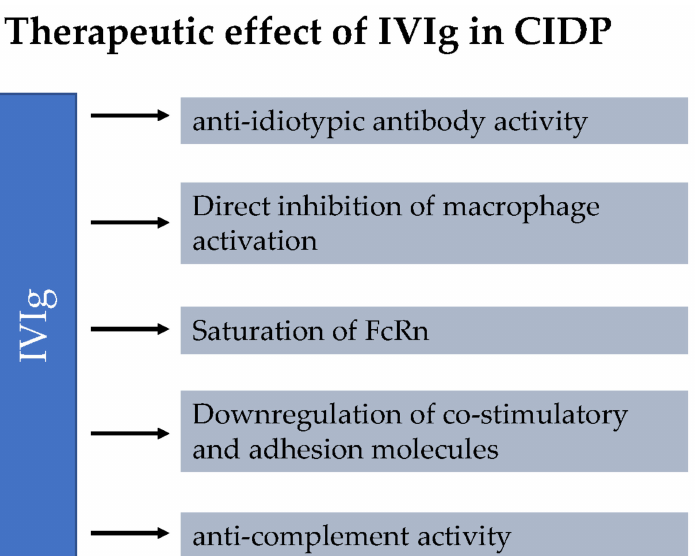
Figure 1. Mechanisms of action of intravenous immunoglobulins (IVIg) in chronic inflammatory demyelinating polyradiculoneuropathy (CIDP). It is hypothesized that the therapeutic effect of IVIg in CIDP is mediated by multiple mechanisms. IVIg treatment inhibits autoantibodies to bind to their antigen (anti-idiotypic effect of IVIg). The saturation of the neonatal Fc receptor (FcRn) leads to reduction of the circulating antibodies. In addition, IVIg seems to have a direct inhibitory effect on macrophage activation and interferes with activation of co-stimulatory molecules and cell-adhesion molecules. IVIg therapy leads to inhibition of complement activity, which is important for antibody-mediated cytotoxicity and macrophage